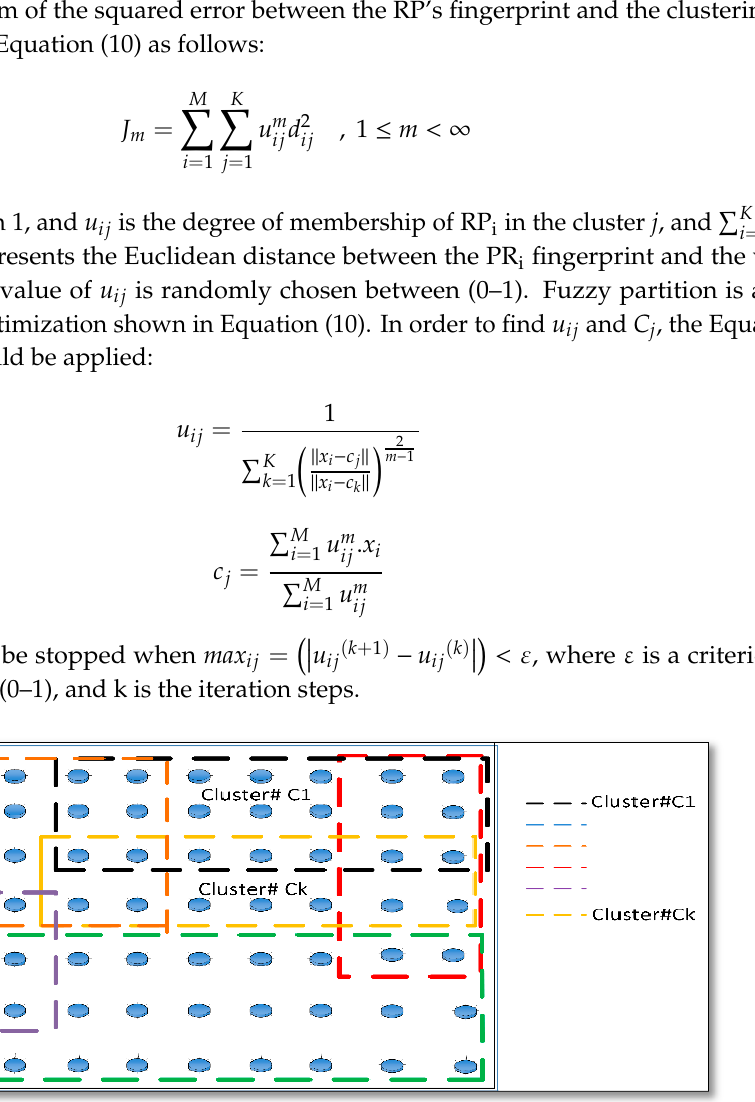
Figure 7. The distribution of RPs on the fuzzy C-means clusters.